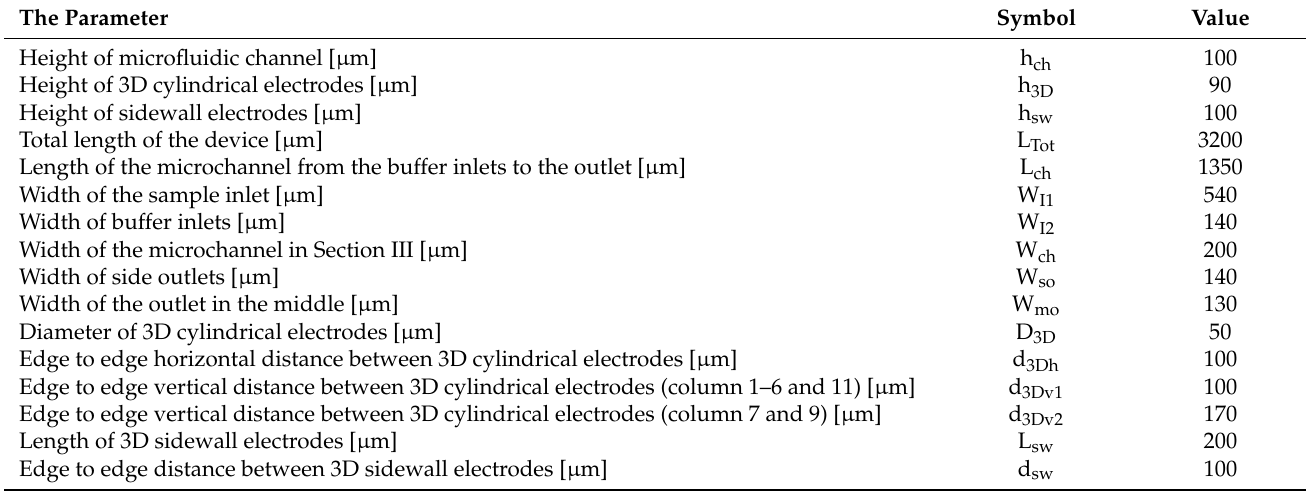
Table 2. Geometric parameters of the proposed microfluidic device.